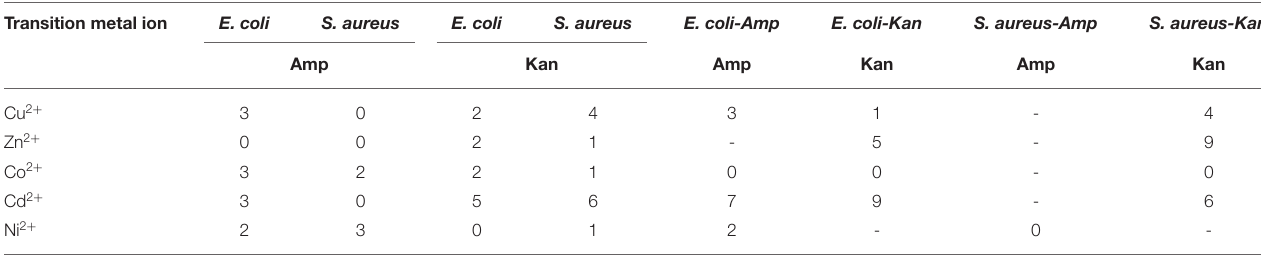
TABLE 3 | Total of significant interactions between transition metal ions and antibiotics. Transition metal